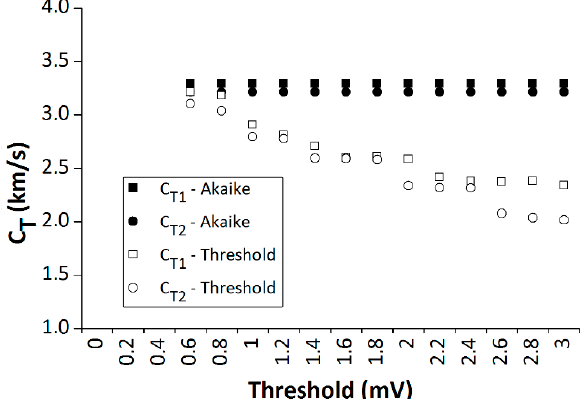
Figure 3. Example: ToF detection using the Akaike method.